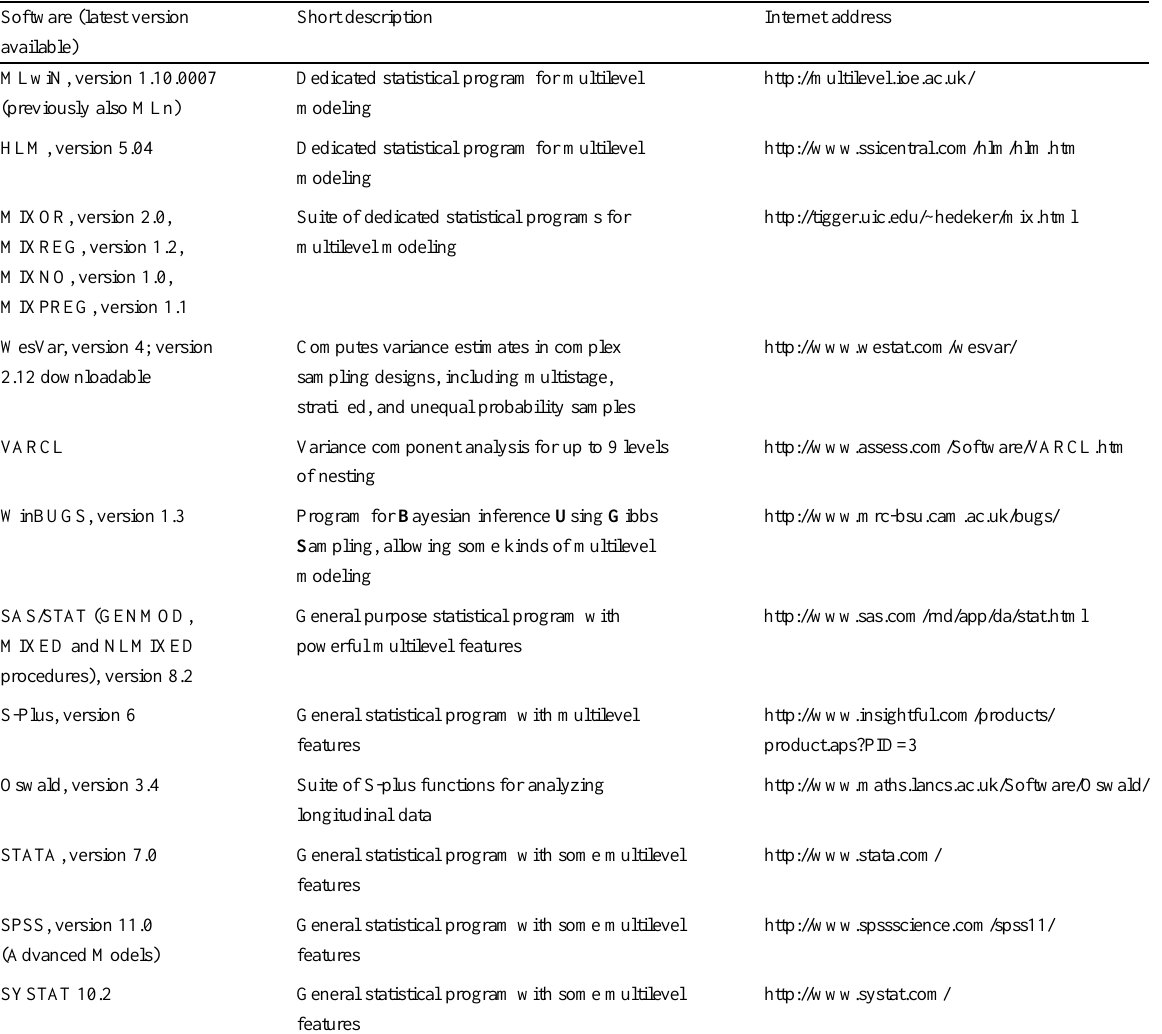
List of software for multilevel modeling or with some “multilevel”